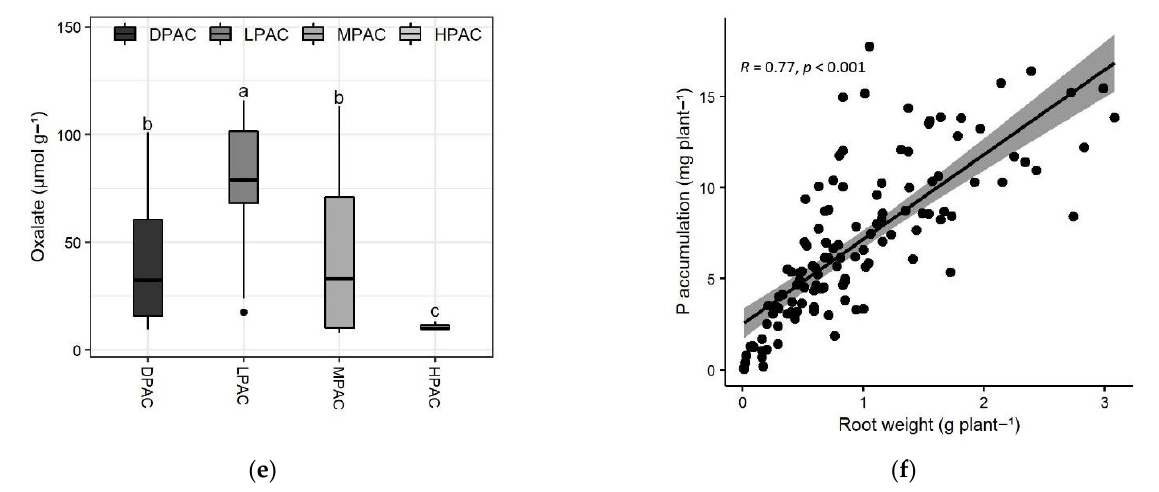
Figure 2. Main root traits of the Chilean quinoa accessions belonging to the different P acquisition classes after 13 weeks of plants growing on a volcanic soil with low available P. Boxplots representing root biomass per plant ( a ), root-to-shoot ratio ( b ), pH in the rhizosphere (1:2.5 soil:water) ( c ), acid phosphatase activity in the rhizosphere ( d ), oxalate concentration in the rhizosphere ( e ), and Pearson correlation analysis between root weight and P accumulation ( f ). Means with different letters are significantly different according to the Tukey HSD test ( p < 0.05). Abbreviations: high P acquisition capacity (HPAC), medium P acquisition capacity (MPAC), low P acquisition capacity (LPAC), and deficient P acquisition capacity